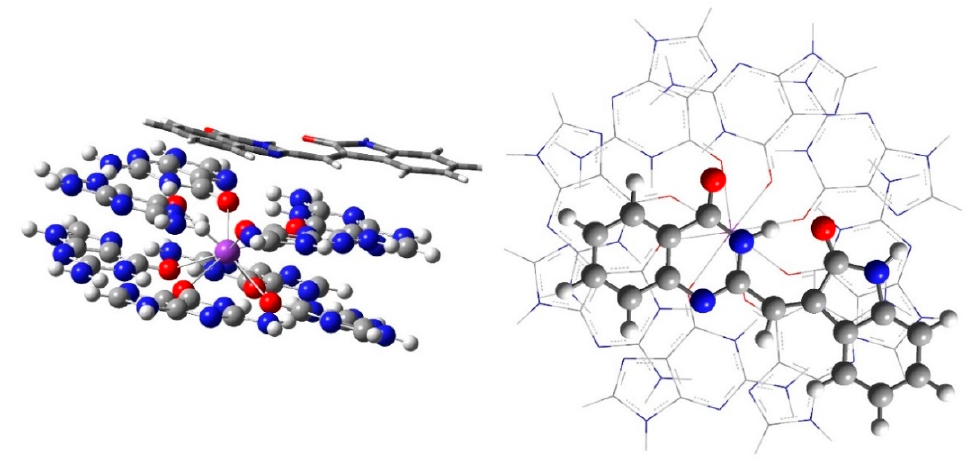
Figure 4. The adduct of schizocommunin, the rigid crescent shape on top, to the model quadruplex, optimized wB97XD/6-31G(d,p) geometry. Oxygen atoms are red, and nitrogen atoms are